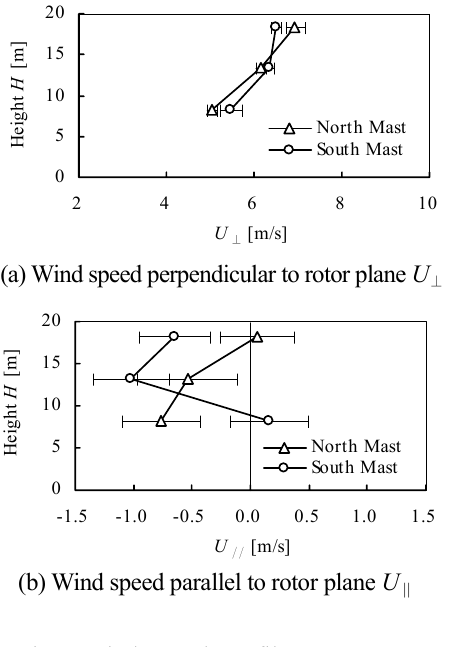
= Fig.8 Wind speed profiles at σ U U ⊥